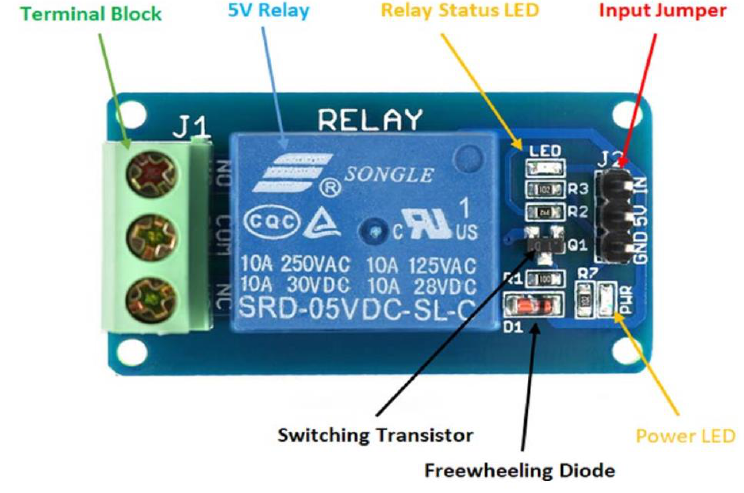
Figure 7. Relay module physical hardware and connection points [36].